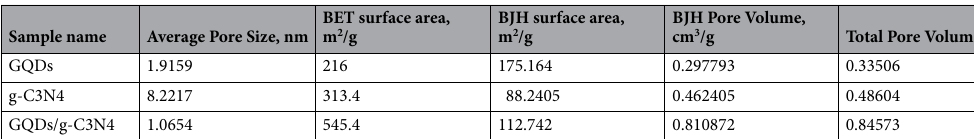
Table 4. The parameters of the complete N2 adsorption–desorption isotherm of all